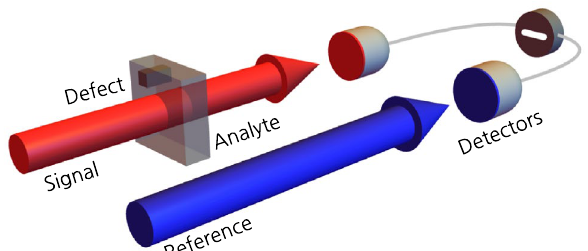
Figure 1. Differential detection scheme for imaging of an absorptive analyte with minute defects. The signal (red) beam passes through the analyte, whereas the reference (blue) beam is kept unchanged. The intensities of the transmitted beams are measured at detectors, yielding their difference via post-processing. The mathematical formulation of the considered imaging scheme is described in the main text, where the photon loss and the background noise are also properly